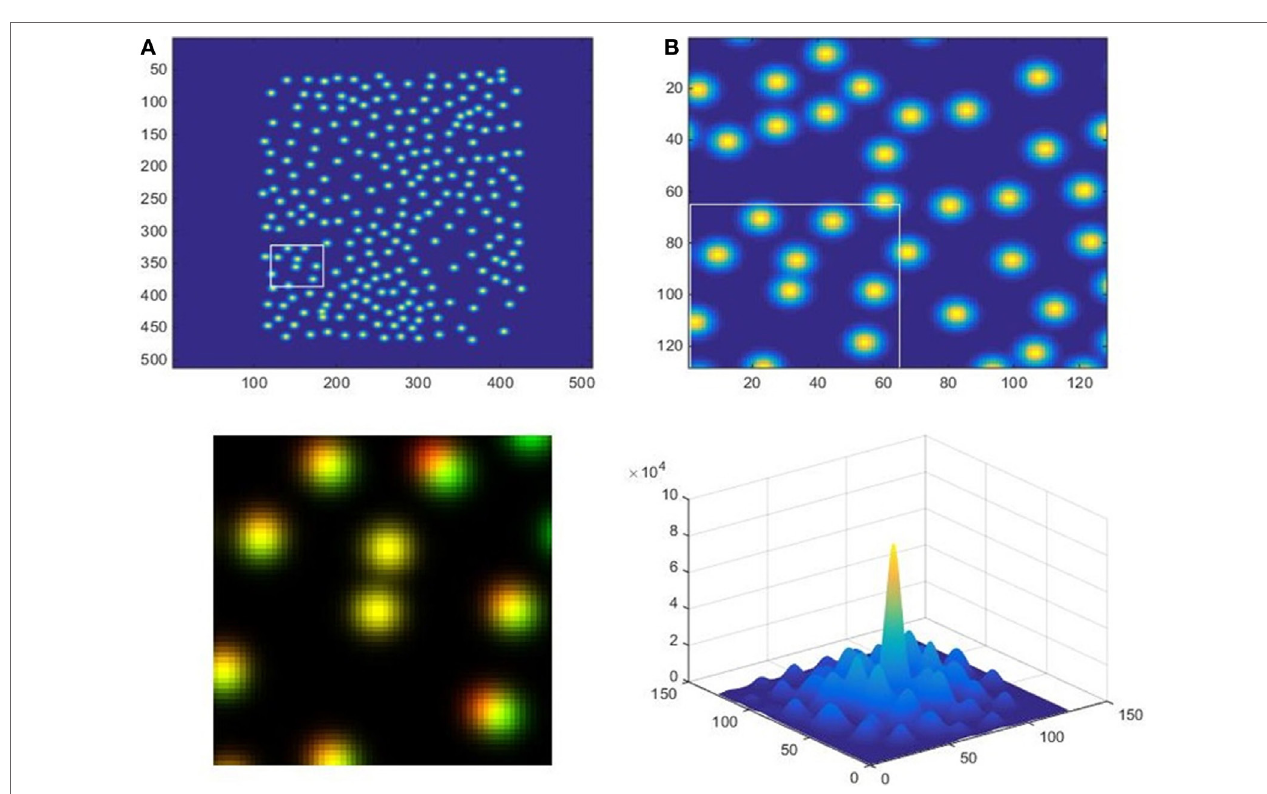
FIgURe 9 | Upper left: the entire image (A) , with a box around the current region being analyzed. Upper right: 1/16th of image (A) , showing which of its quadrants (1/64th of the whole) is currently the focus. Lower left: blend of the two boxed regions, with red = image (A) , green = image (B) , and yellow = overlap. Lower right: cross-correlation of the two regions, with the peak giving the shift